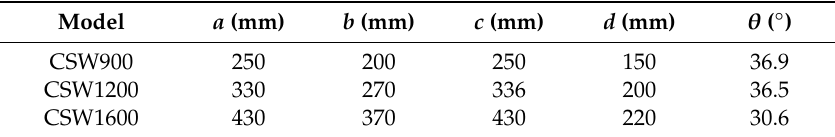
Table 7. Studied geometries of CSWs.